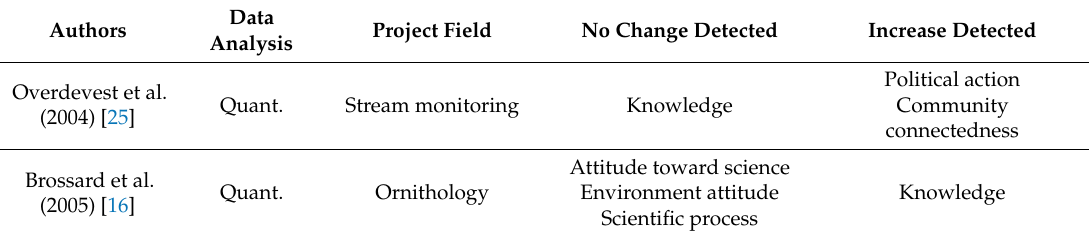
Table 1. Quantitative (quant.) and mixed (quantitative and qualitative) data analysis approaches and project outcomes for various citizen science evaluation